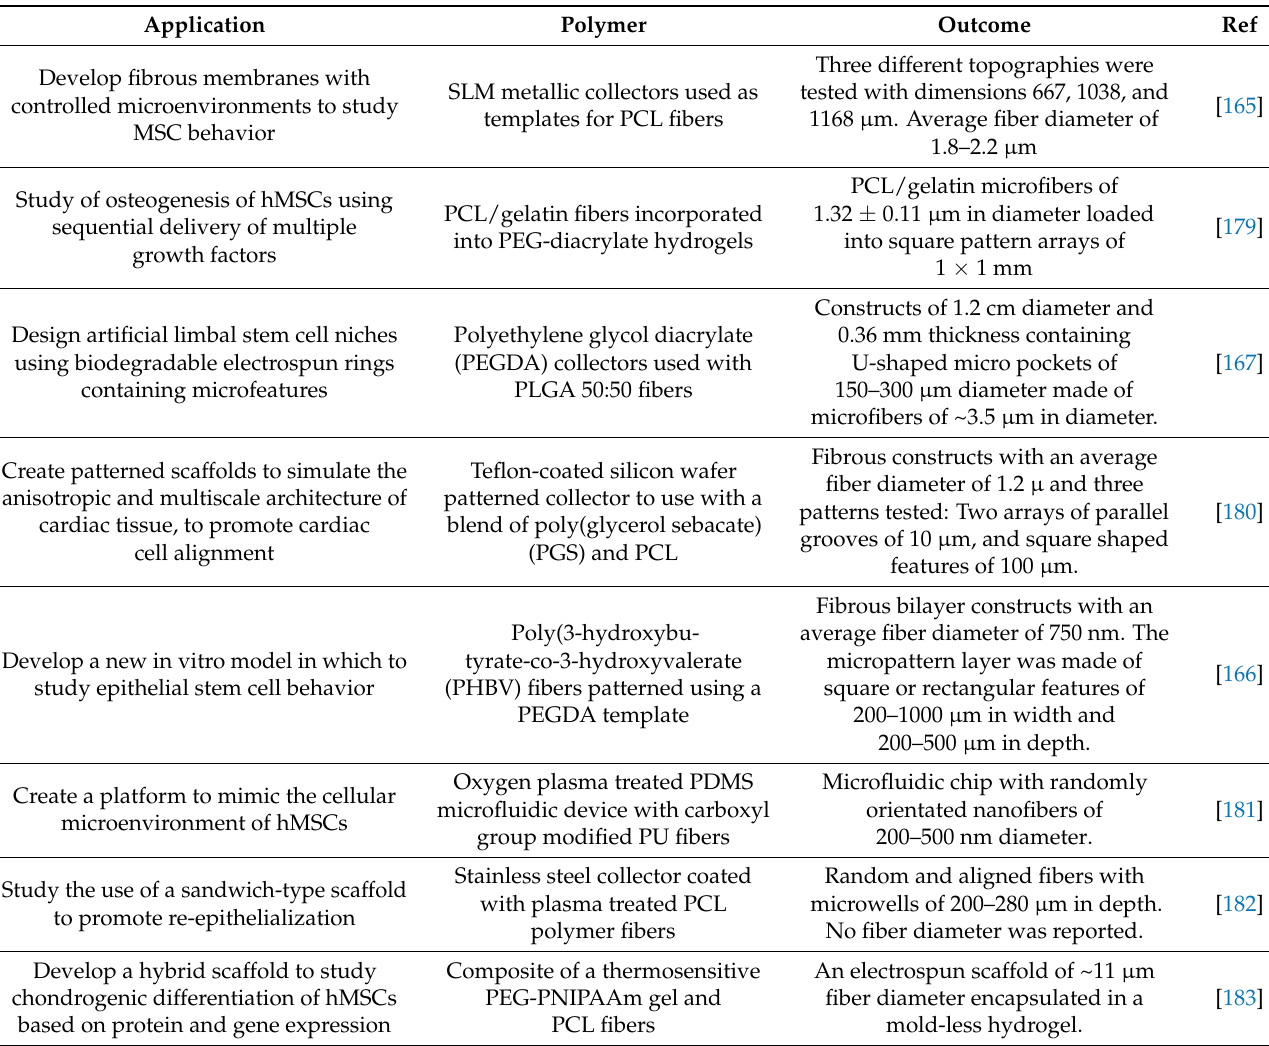
Table 6. Summary of tissue engineered devices created to replicate the micro and nano spatial cues of the stem cell niche by combining two or more fabrication techniques. Application Polymer